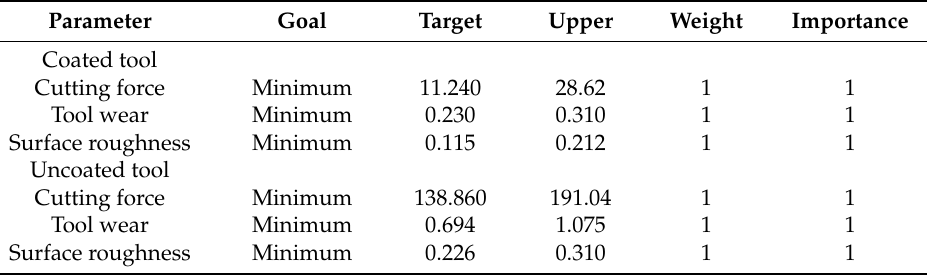
Table 12. The response optimization results.